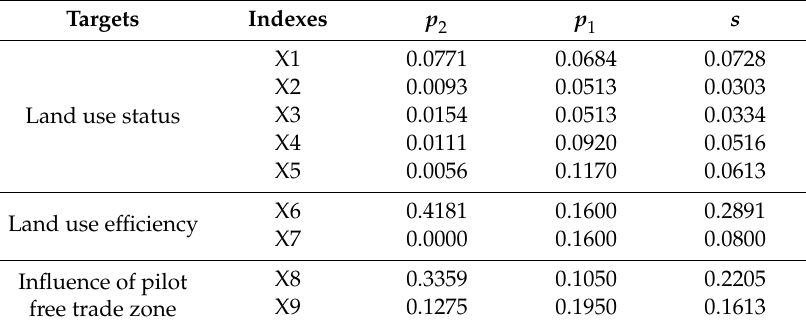
Table 7. Determination of comprehensive weights.